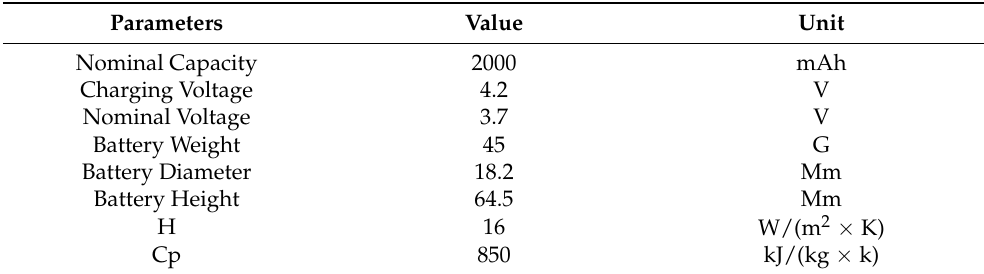
Table 1. Battery